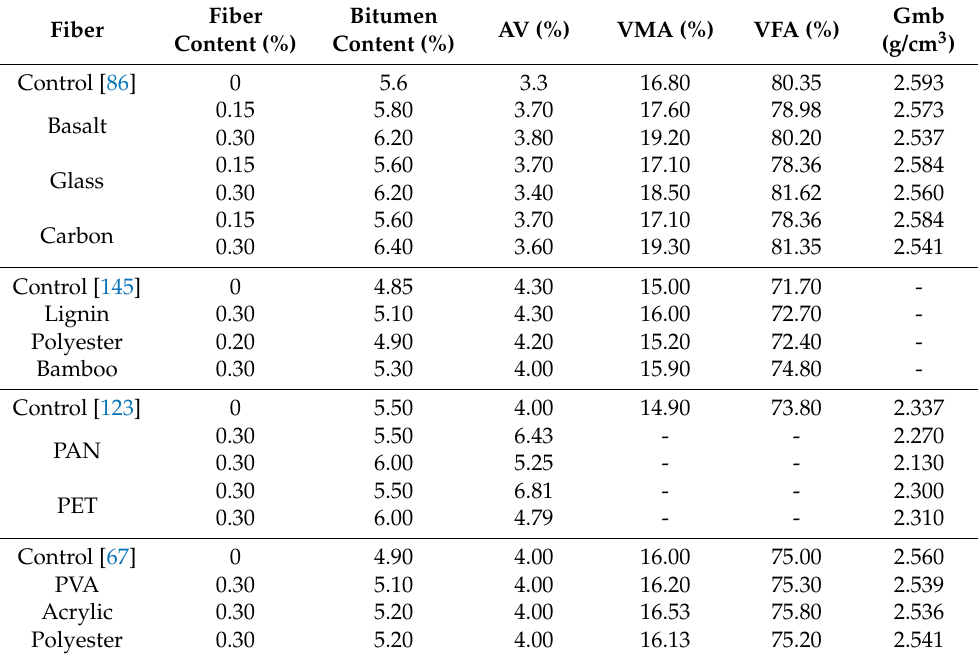
Table 4. Influence of adding fibers on the volumetric properties of asphalt